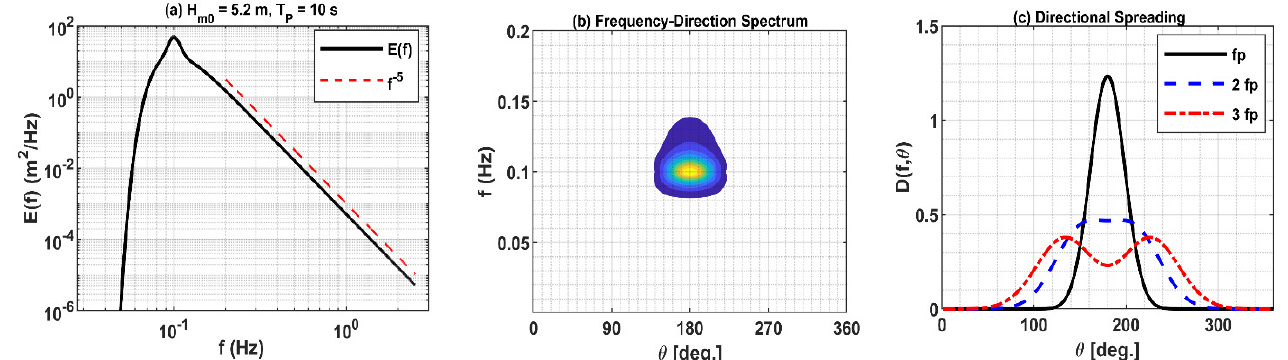
Figure 1. Examples of water surface regions simulated using linear (Fourier) numerical modeling approximately covered by the footprints of ( a ) the Radar (5 m × 5 m ) and ( b ) the Laser (0.15 m × 0.15 m ) beams.